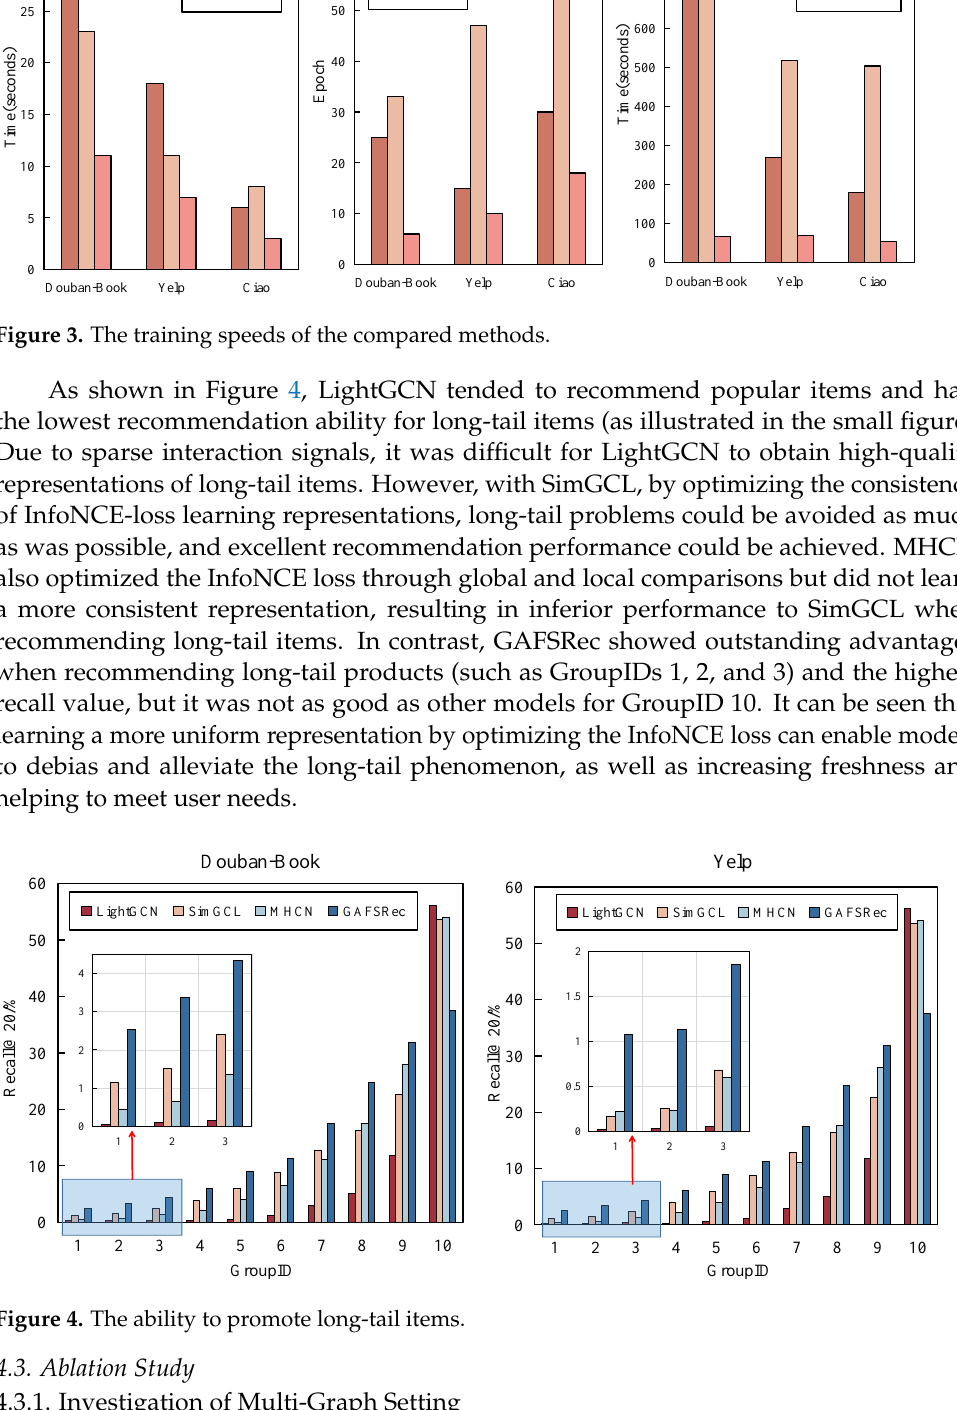
Figure 5. Contributions of each graph with different datasets. Obviously, for the Douban-Book dataset, due to the low effective social density of the dataset, the explicit user view had little influence on the recommendation, while the recommendation performance of the view lacking the implicit user dropped sharply, in- dicating that the implicit user was the user. Items that met user needs were recom- mended, proving the key role of implicit users for recommendation. For the Yelp and Ciao datasets, due to the higher effective social density of the datasets, explicit user views had a greater impact on the recommendation. Figure 6 visualizes each graph ’ s attention score (median attention score for training set users), revealing that the implicit user had the highest attention score, while the explicit user and the joint graph had low attention scores. According to the findings shown in Figures 5 and 6, implicit users contributed significantly to the analysis of user preferences while explicit users played a greater role when the social density was high, and the joint graph did not necessarily bring greater benefits due to social noise.